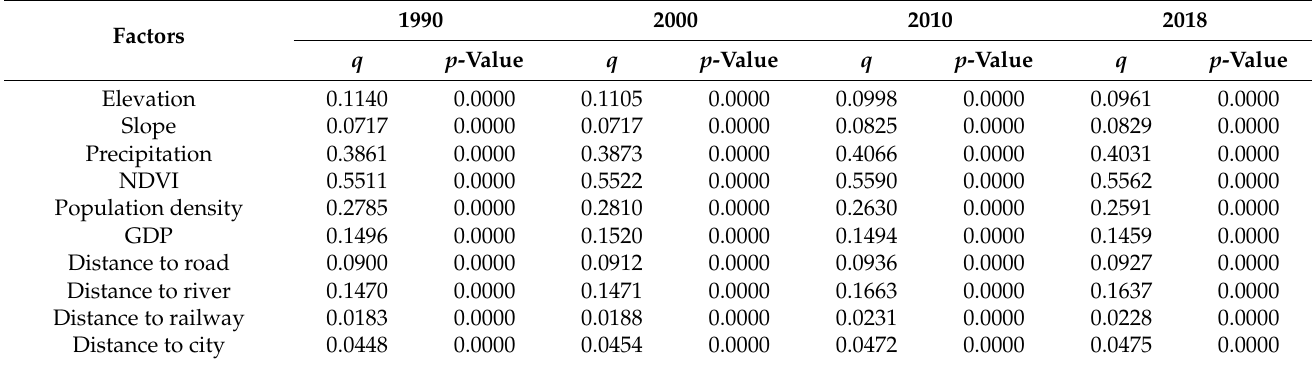
Table 6. The results of Factor Detector for the spatial heterogeneity of average ESV in the YRB during 1990–2018.